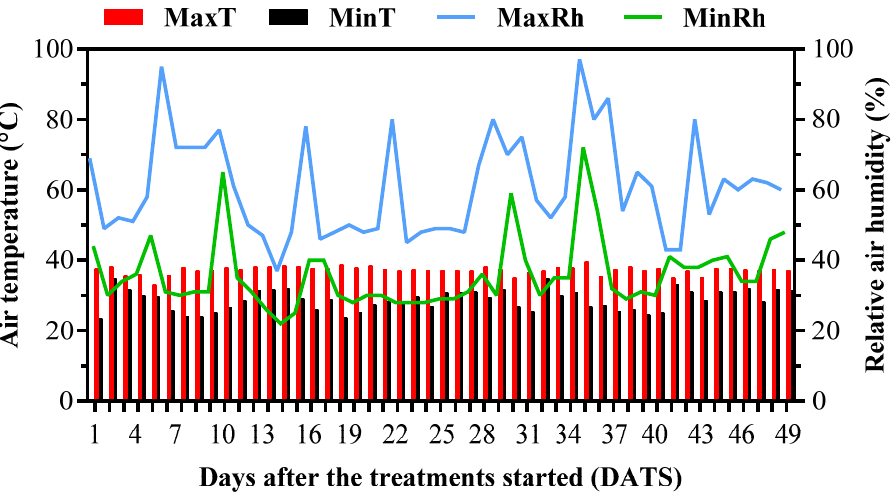
Figure 1. Climate data registered during the experimental period. Maximum air temperature (MaxT) ( ◦ C), minimum air temperature (MinT) ( ◦ C), maximum relative air humidity (MaxRh) (%), minimum relative air humidity (MinRh)